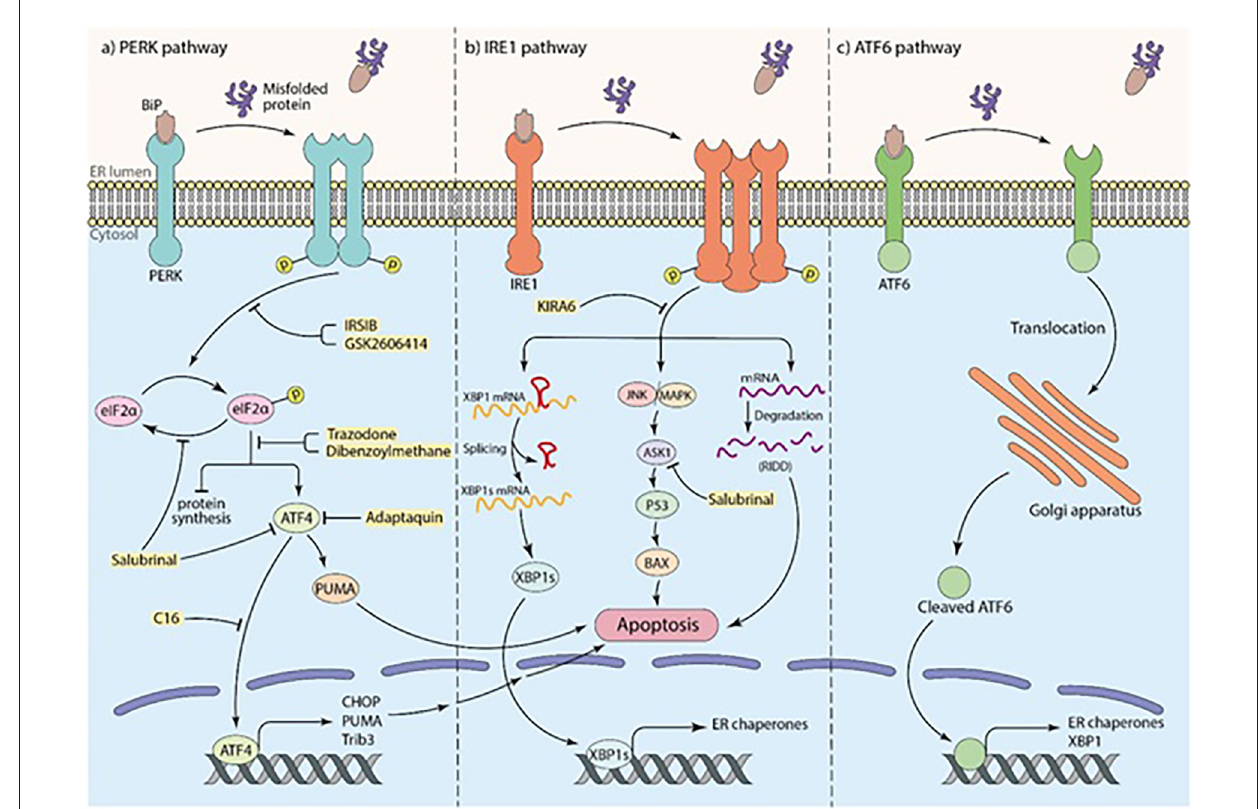
FIGURE1 The role of three arms of UPR in inducing apoptosis and the neuroprotective effects of particular inhibitors (shown in yellow box). (A) The PERK pathway: interaction of substrate binding domain of BiP with misfolded or aggregated proteins leads to BiP dissociation, dimerization, and autophosphorylation of PERK, which further causes eIF2 α phosphorylation. Phosphorylated eIF2 α induces cell death by transcription of apoptotic factors by means of ATF4 transcription factor as well as inhibition of protein synthesis. (B) The IRE1 pathway: after dissociation of BiP from IRE1 receptor by misfolded or aggregated proteins in the ER lumen, IRE1 undergoes oligomerization and autophosphorylation. This results in mRNA degradation termed “regulated IRE1alpha-dependent decay” (RIDD) and inducing apoptotic factors by initiating JNK/MAPK cascade. To mitigate ER stress, the IRE1 pathway also leads to XBP1 mRNA splicing to transcript ER chaperones to improve ER machinery. (C) The ATF6 pathway: translocation of ATF6 to the Golgi apparatus as a result of BiP dissociation, and the proteolysis of ATF6 in Golgi brings out an activated ATF6 transcription factor to transcript ER chaperones and XBP1 for ER